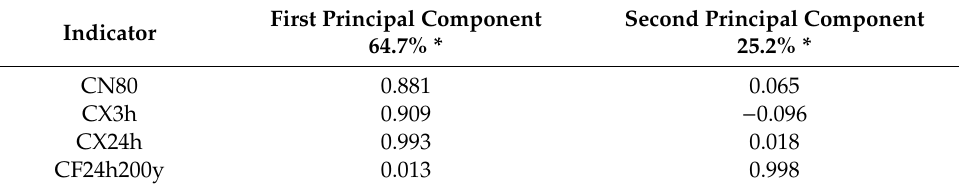
Table 5. Matrix of factor loadings of climate exposure.